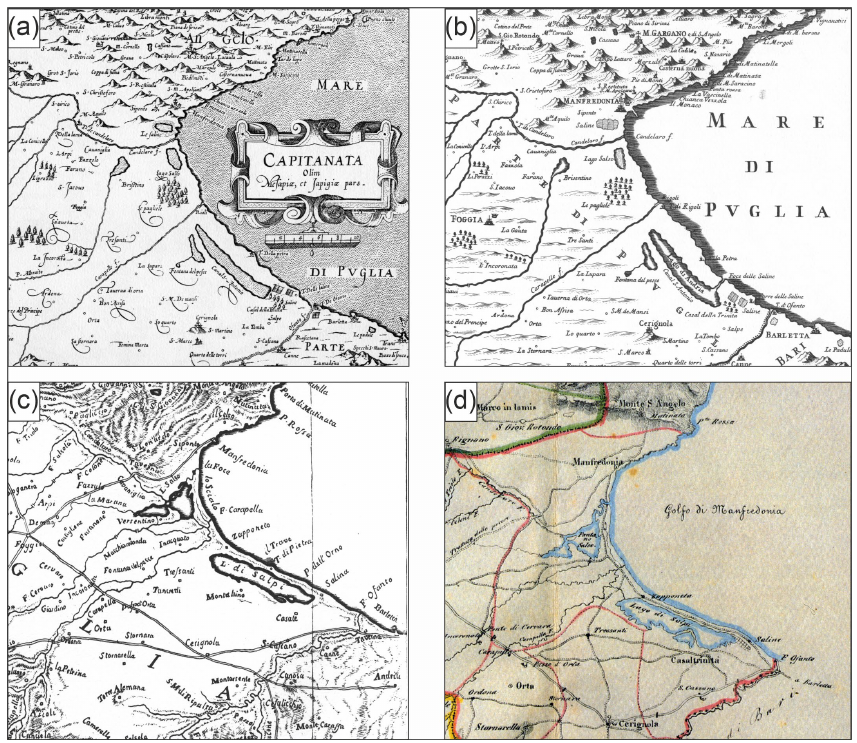
Figure 2. Coastal area of Tavoliere di Puglia plain as represented in the main cartographical products available for the XVII and XX centuries . ( a ) Magini, 1620 [59], ( b ) De Rossi, 1714 [60], ( c ) Rosati, 1787 [61]; ( d ) Marzolla, 1832